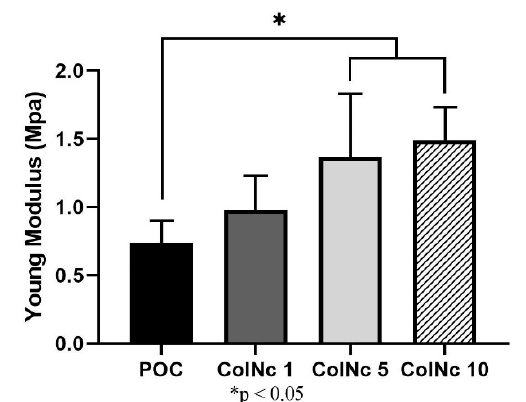
Figure 6. Mechanical profile of pure ovine collagen (POC) against various concentration of composite BHS. Study proved that mechanical strength varies proportionally with concentration of nanocellulose in the BHS. (*) represents a significant difference ( p < 0.05; n = 3) with POC group.